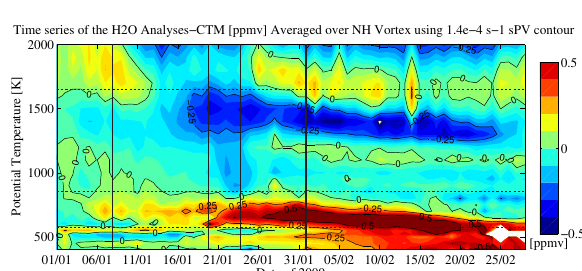
series of the H2O Analyses−CTM [ppmv] Averaged over NH Vortex using 1.4e−4 s−1 sPV contour